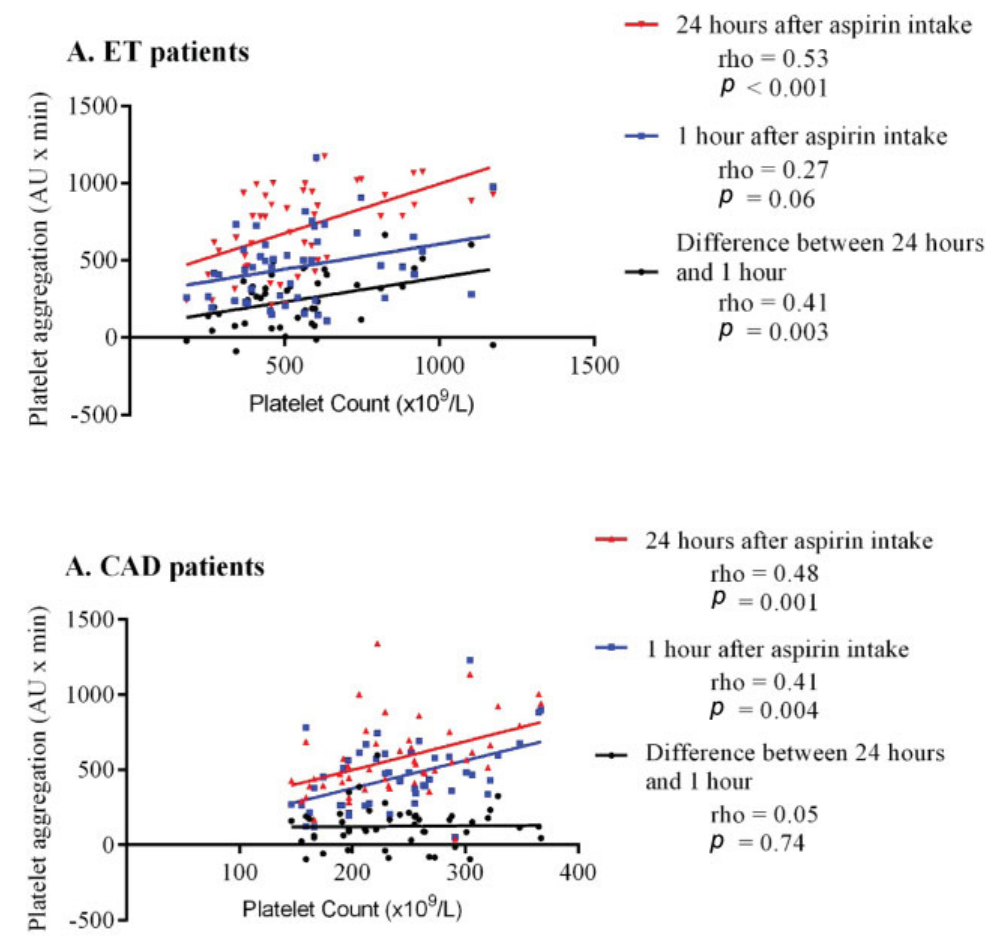
Fig. 1 Correlation between platelet aggregation and platelet count: (1) 24hours after aspirin intake, (2) 1hour after aspirin intake, and (3) difference between 24 and 1hour in A : 48 patients with essential thrombocythemia (ET) and B : 48 patients with coronary artery disease (CAD).